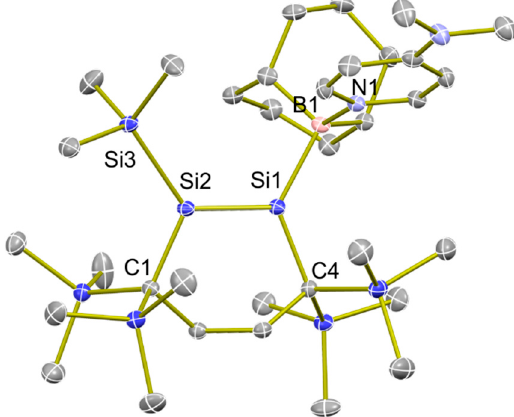
Figure 6. Preliminary XRD analysis of 5 (atomic displacement parameters set at 50% probability; hydrogen atoms omitted for clarity).